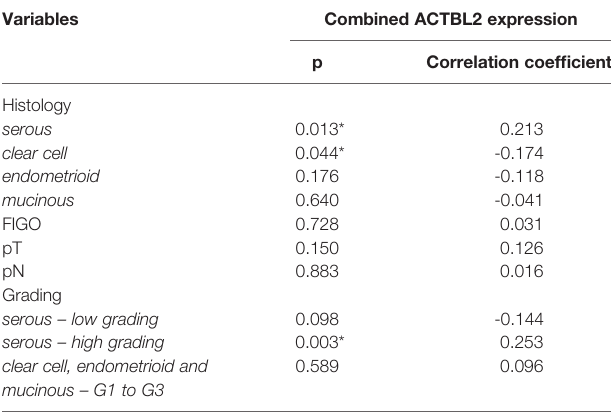
TABLE 2 | Correlation analysis of ACTBL2 expression and clinicopathological